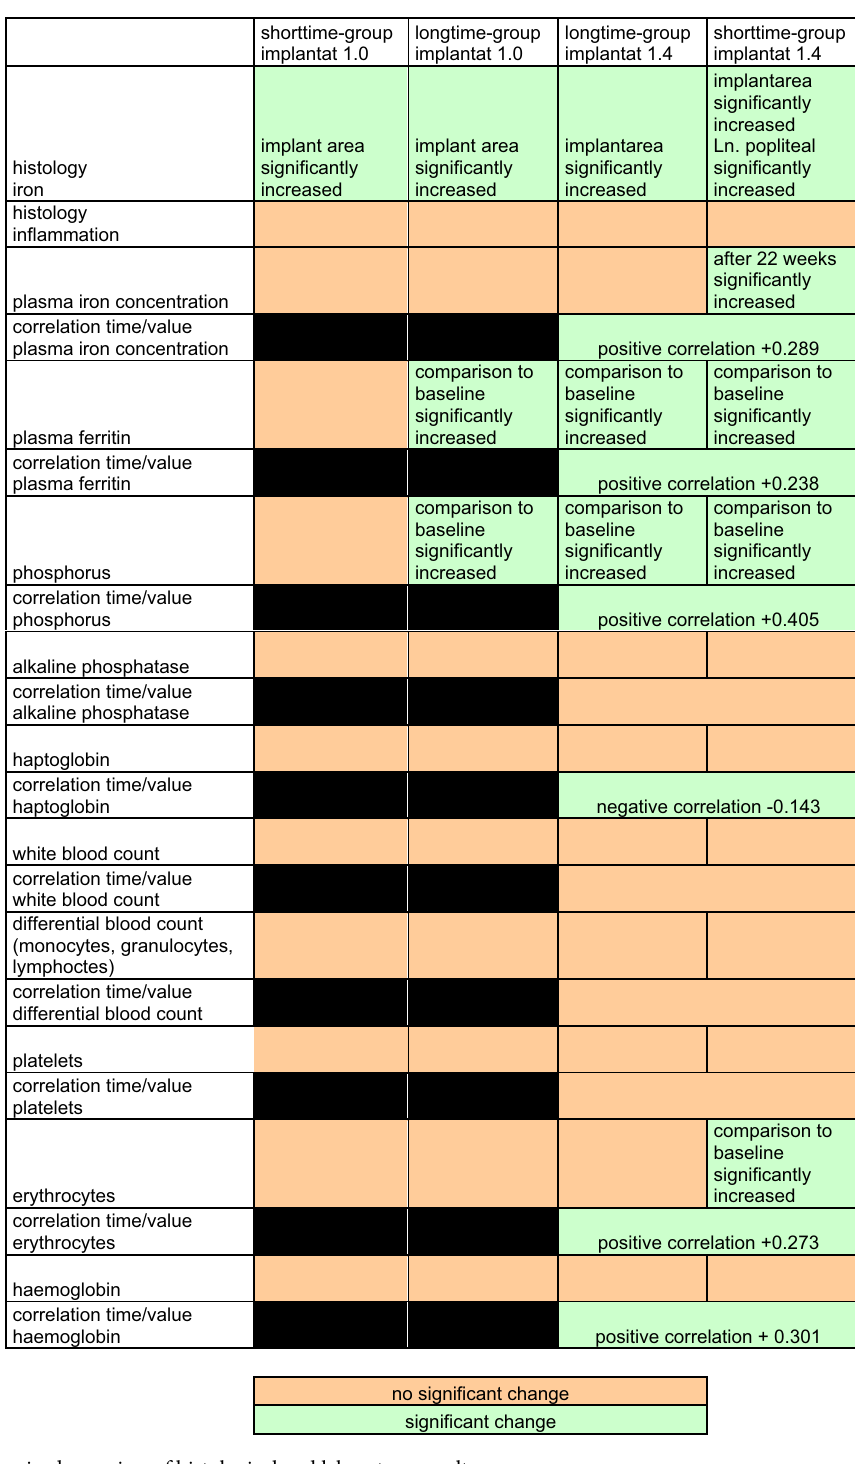
Table 1. Summarized overview of histological and laboratory